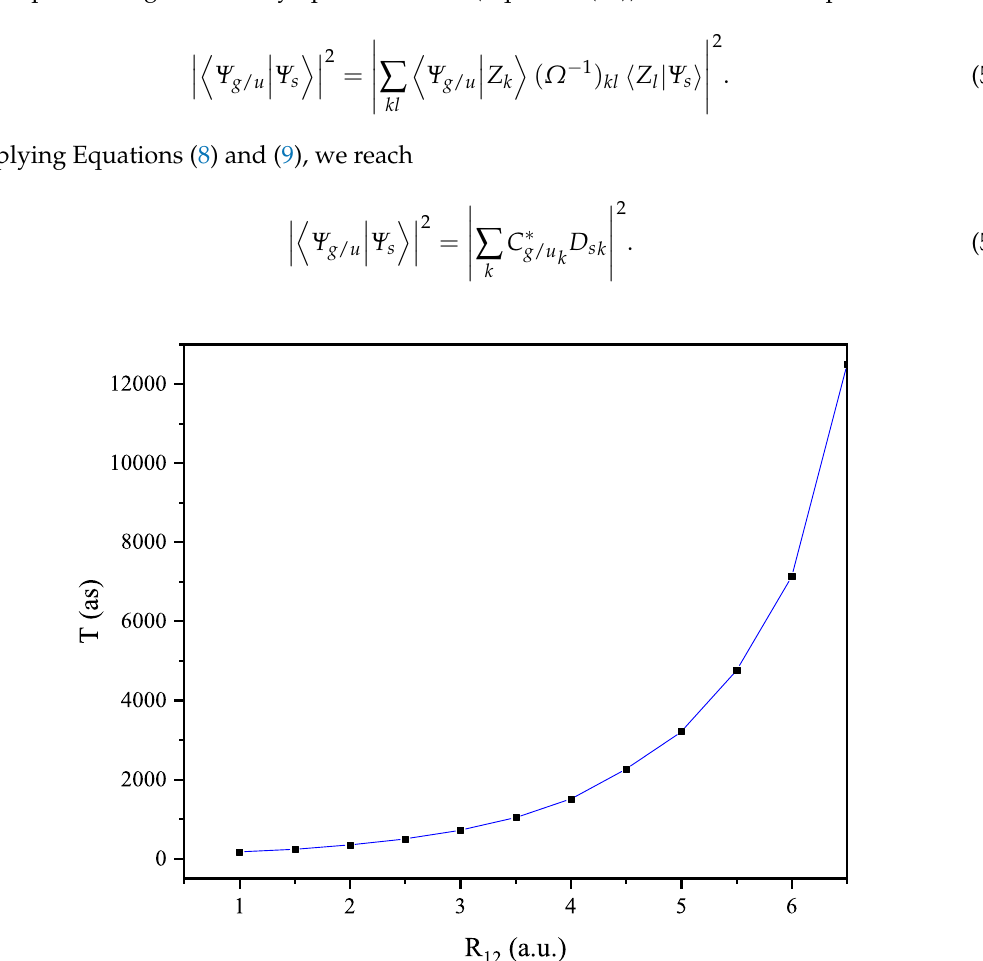
Figure 4. The charge migration period computed by employing Equation (50) for different inter-nuclear distances in H + in the absence of an ultra-short intense laser 2